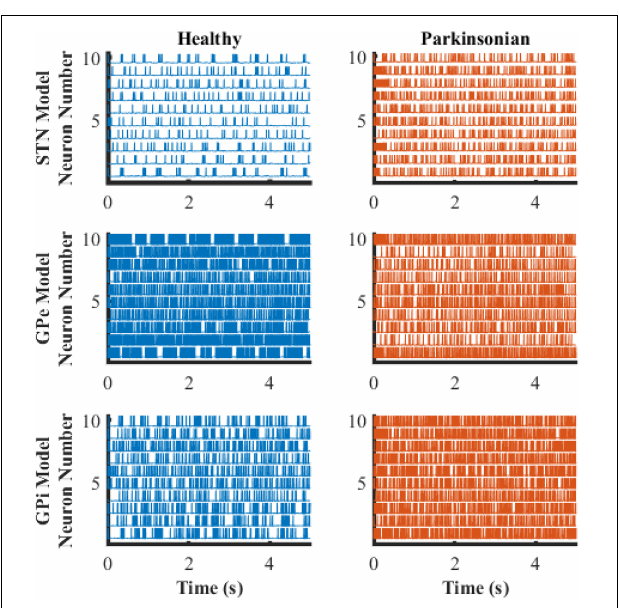
FIGURE 3 | Transmembrane potential as a function of time of model neurons in STN, GPe, and GPi. The blue traces depict model neuron activity in the healthy condition while orange traces depict model neuron activity in the Parkinsonian